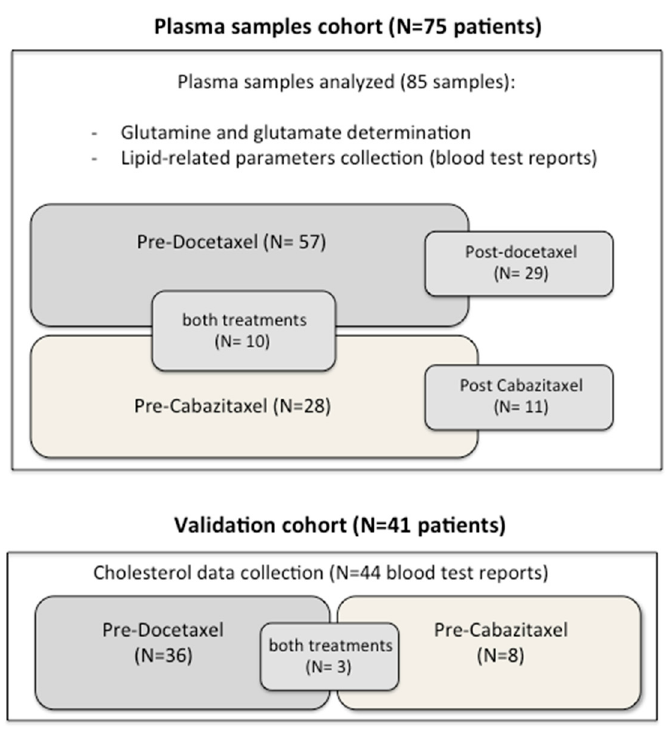
Figure 1. Scheme of the patients included in this study. N : number of patients. Table 1. Patients’ characteristics.